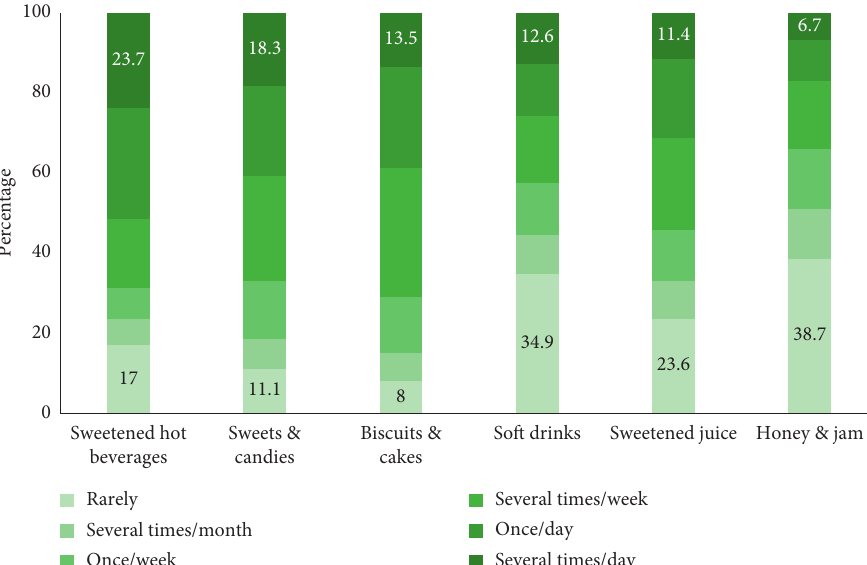
Figure 1: Frequency of consuming sweet products.